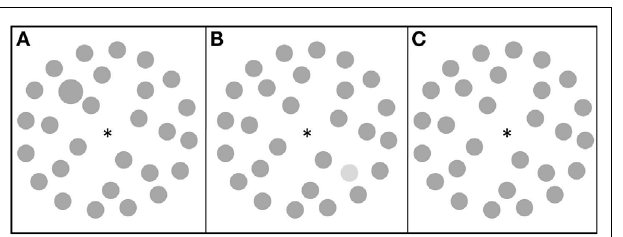
FIGURE 2 |Visual search stimuli: (A) a size target display; (B) a luminance target display; (C) a blank display.